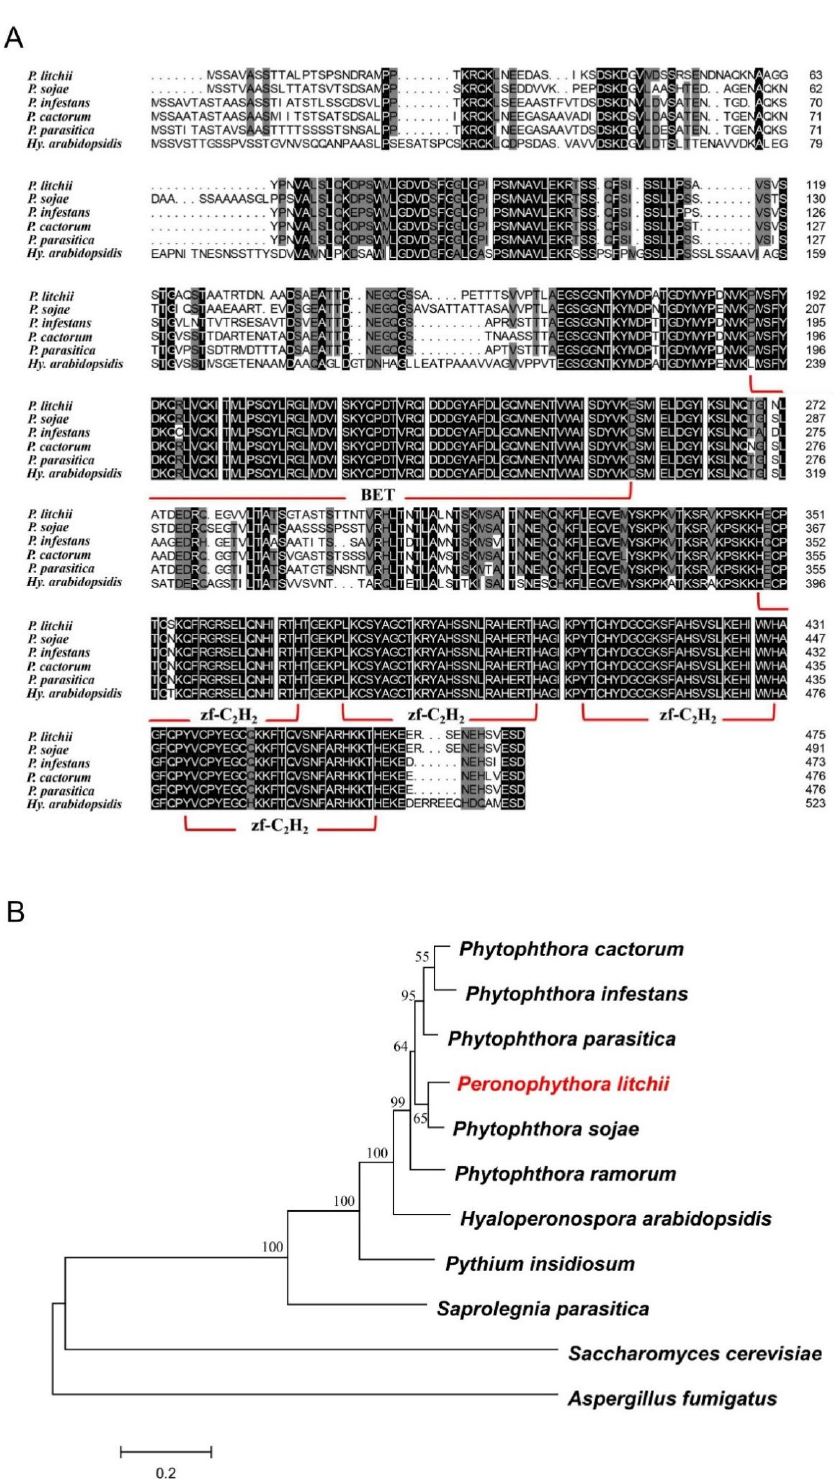
Figure 1. Domain arrangement and phylogenetic analysis with PlCZF1 protein and its orthologs.